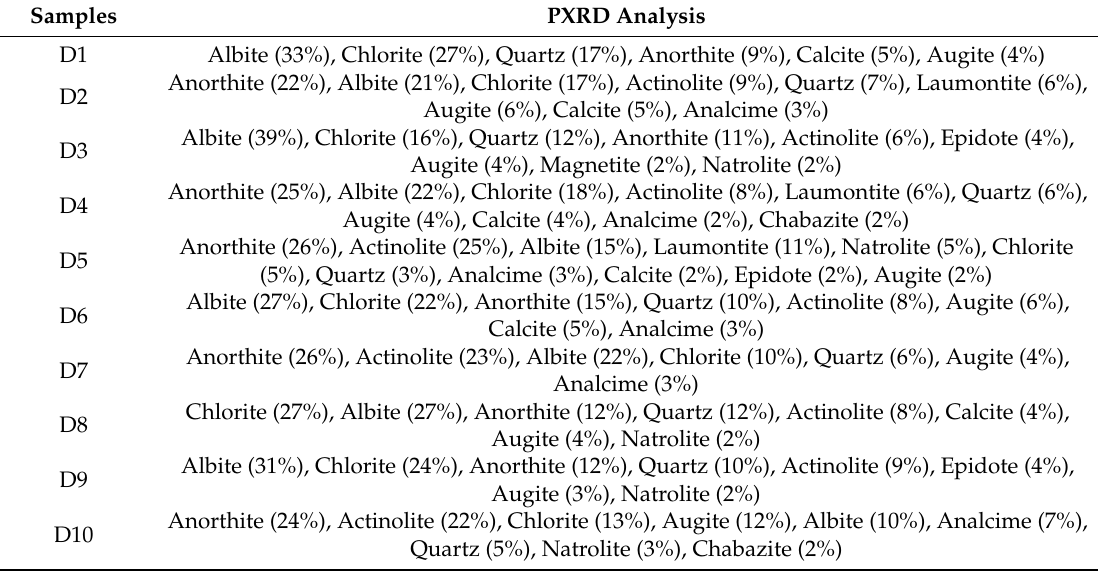
Table 3. PXRD analyses of fine aggregates (only the main crystalline phases are shown). Samples PXRD